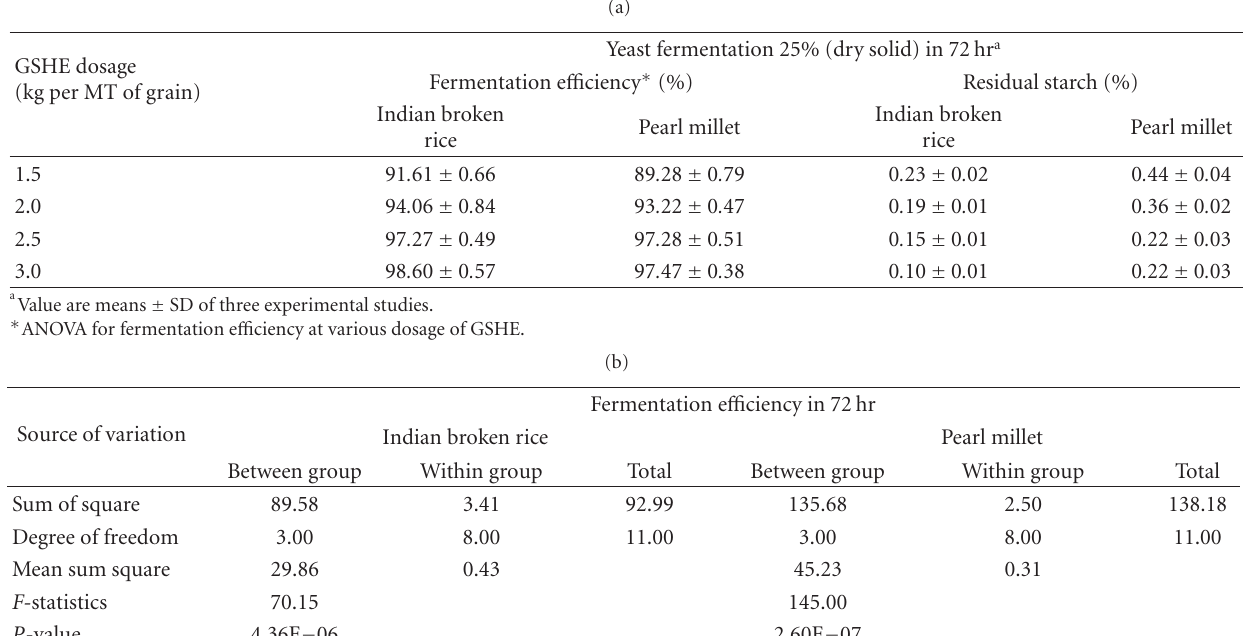
Table 2: Fermentation e ffi ciency and residual starch in 72hr of cycle at various dosage of GSHE under yeast fermentation having 25% dry solid of broken rice and pearl